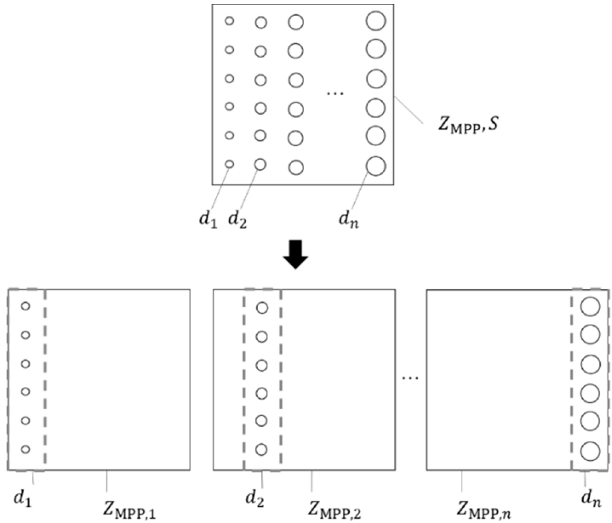
Figure 1. Diagrams of the hypothetical MPPs. The upper MPP is the original MPP, and the lower MPPs are the hypothetical MPPs, which have holes of different diameters only in surface area S .